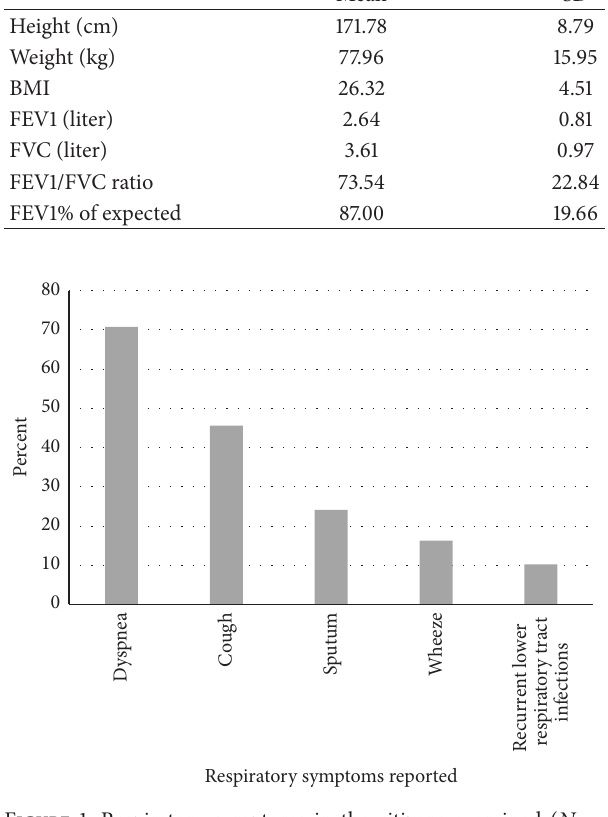
Figure 1: Respiratory symptoms in the citizens examined ( 𝑁 = 1 ,499).